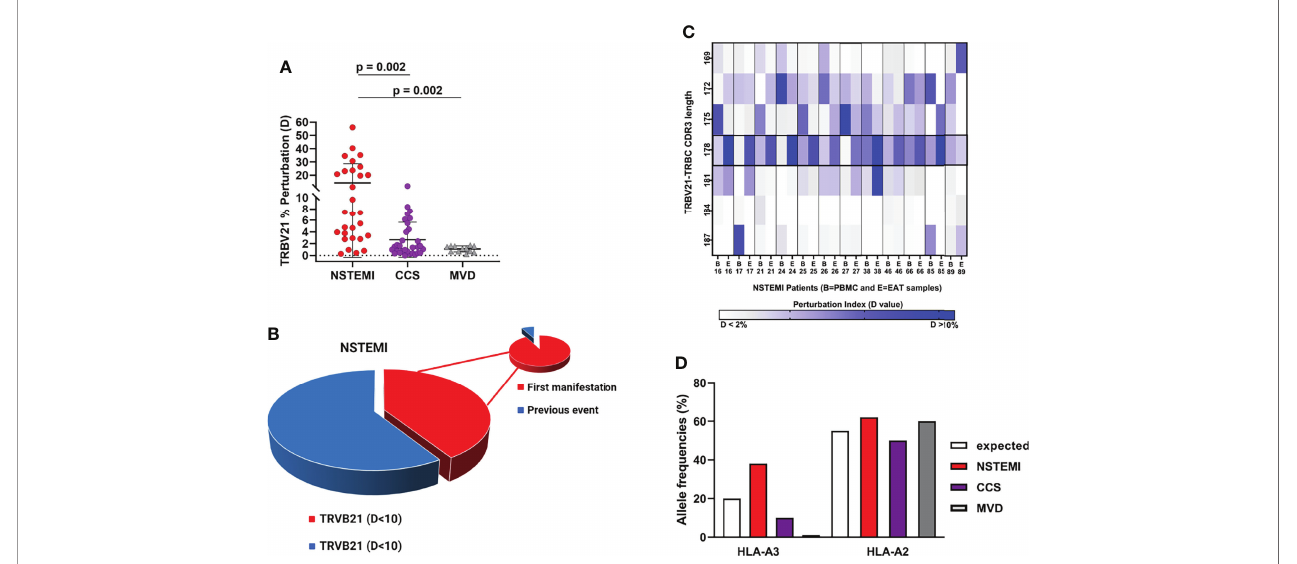
FIGURE 4 | Quantitative analysis of TRBV21 perturbation. (A) Comparison of the TRBV21 perturbations in the three groups of patients. The TRBV21 average perturbation between EAT and PBMC samples is different in the three groups of patients (ANOVA for trends P < 0.001). It is signi fi cantly higher in NSTEMI patients as compared with CCS and MVD patients ( P < 0.01 for both comparisons), but similar between CCS and MVD patients. This analysis revealed a perturbation threshold of 10% for TRBV21. (B) Pie chart showing the percentage of NSTEMI with TRVB21 D > 10% (41%) and the proportion of patients at their fi rst event (pie of pie chart) (92%). (C) Quantitative analysis of TRBV21 perturbation in NSTEMI patients. NSTEMI patients with high perturbation of TRBV21 ( D > 10%) are displayed in the matrix with dark blue rectangles, highlighting that the most frequently perturbed peak is the 178-bp length. (D) Frequency (%) of HLA-A*02+ and HLA-A*03+ in the three groups of patients tested. HLA-A*03 + frequency is higher in the NSTEMI group (38%) than in the CCS group (10%). In MVD patients, A3 was not present in the analyzed cohort. The graph shows the expected frequency of HLA-A in a reference Caucasian population deduced from http://allelefrequencies.net (>110,000 individuals). As a referral, we also reported the frequency of the commonly used HLA in the Caucasian